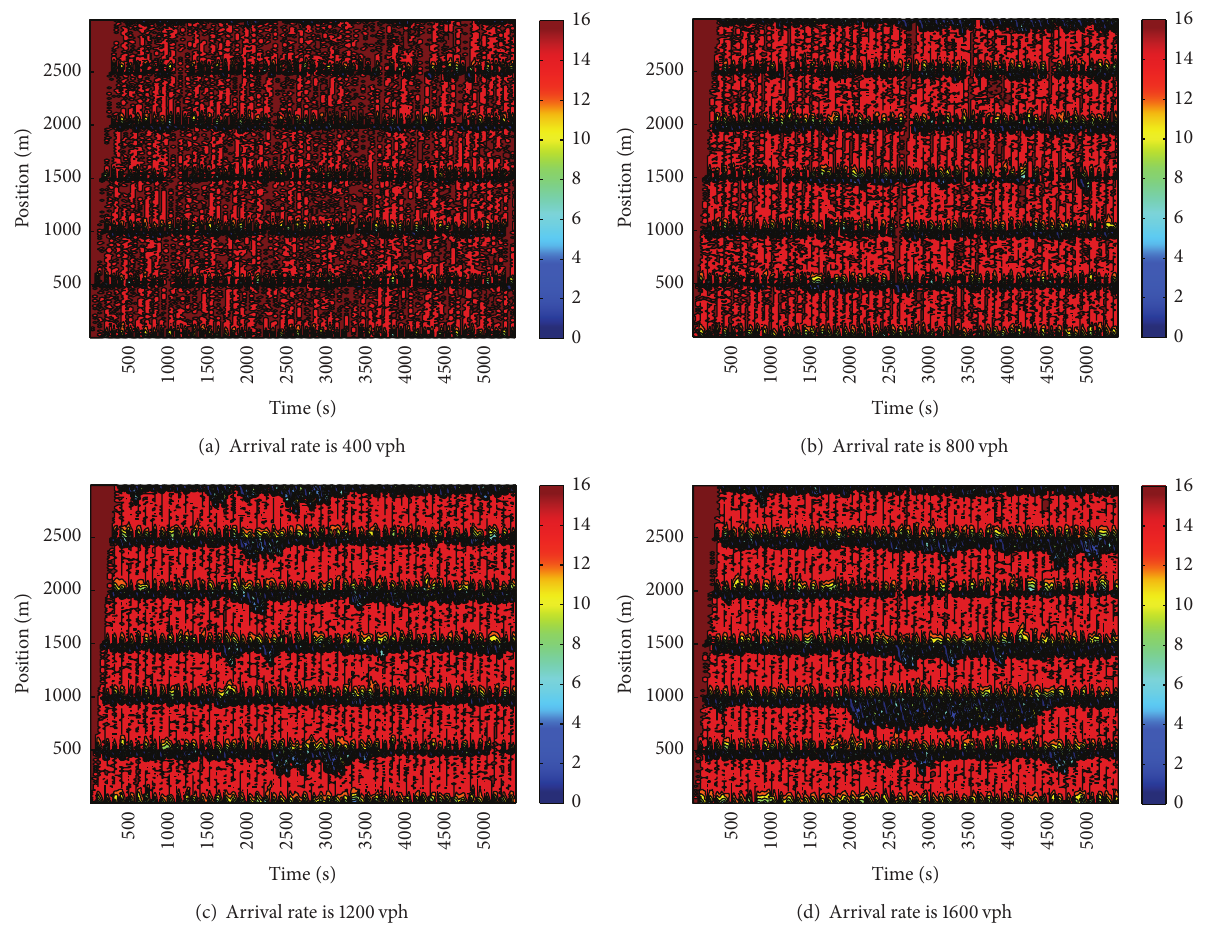
Figure 11: Speed contour plot in vehicle-actuated traffic signals.